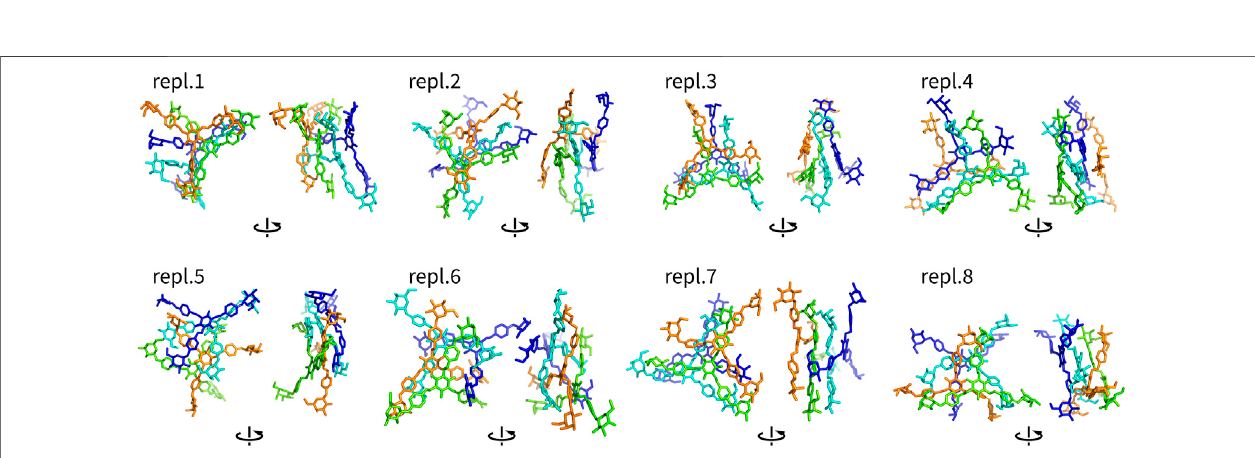
FIGURE 4 | Assemblies Y4 (non-hydrogen atoms) after 100 ns shown in two different orientations rotated by 90 ° . They are colored by atom ID in the system.